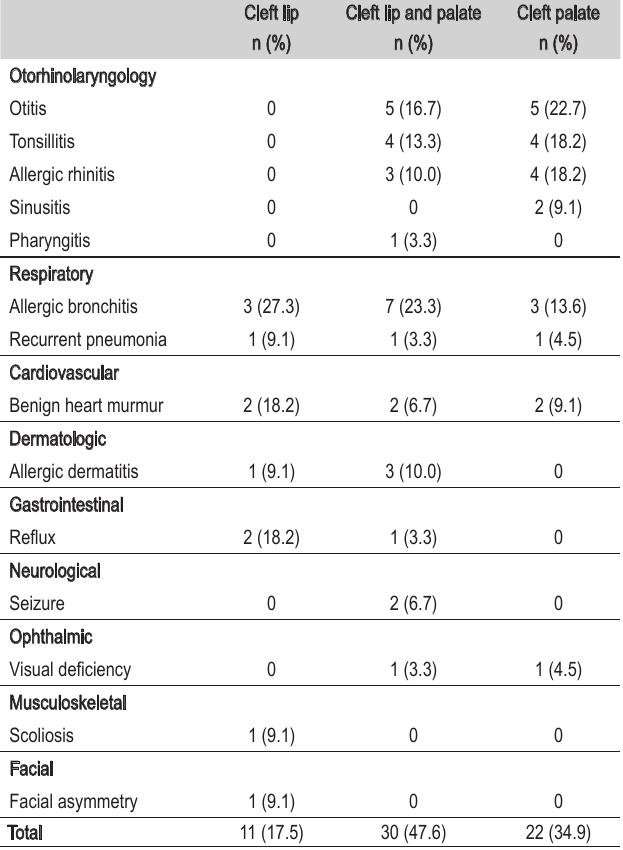
Table 2 - Distribution of systemic alterations in patients with nonsyndromic cleft lip and/or